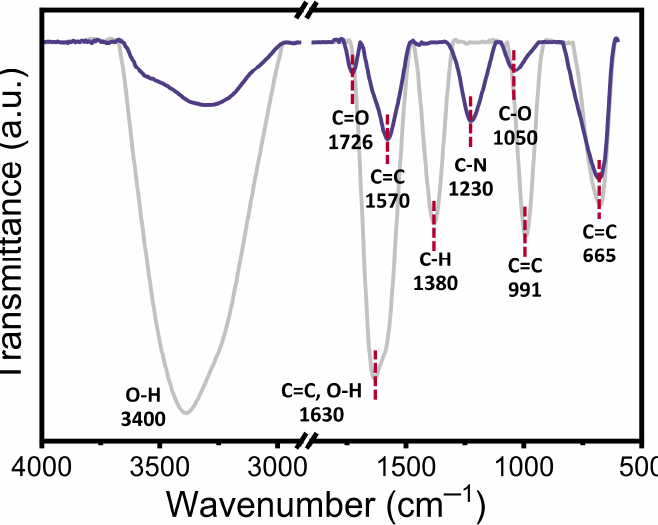
Figure 4. FTIR spectra of GO (gray) and rGO without cells (purple). The peak at ∼ 1570 cm − 1 corre- sponded to C=C stretching emerging after GO reduction. Additionally, the characteristic absorption peak at ~1230 cm − 1 was detected in rGO corresponding to N-H bending and C-N stretching.